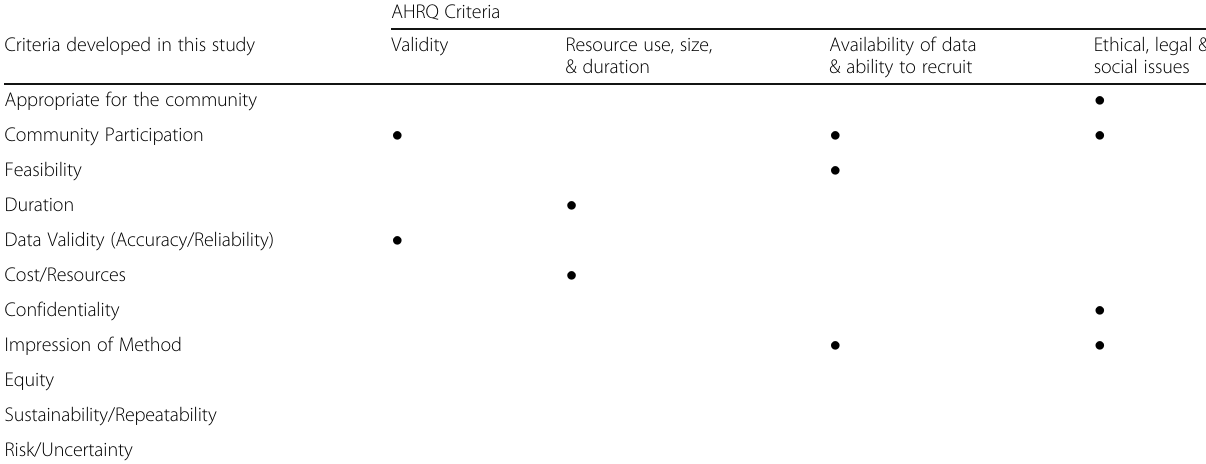
Table 2 Criteria developed in this study and their relationship to the AHRQ framework criteria AHRQ